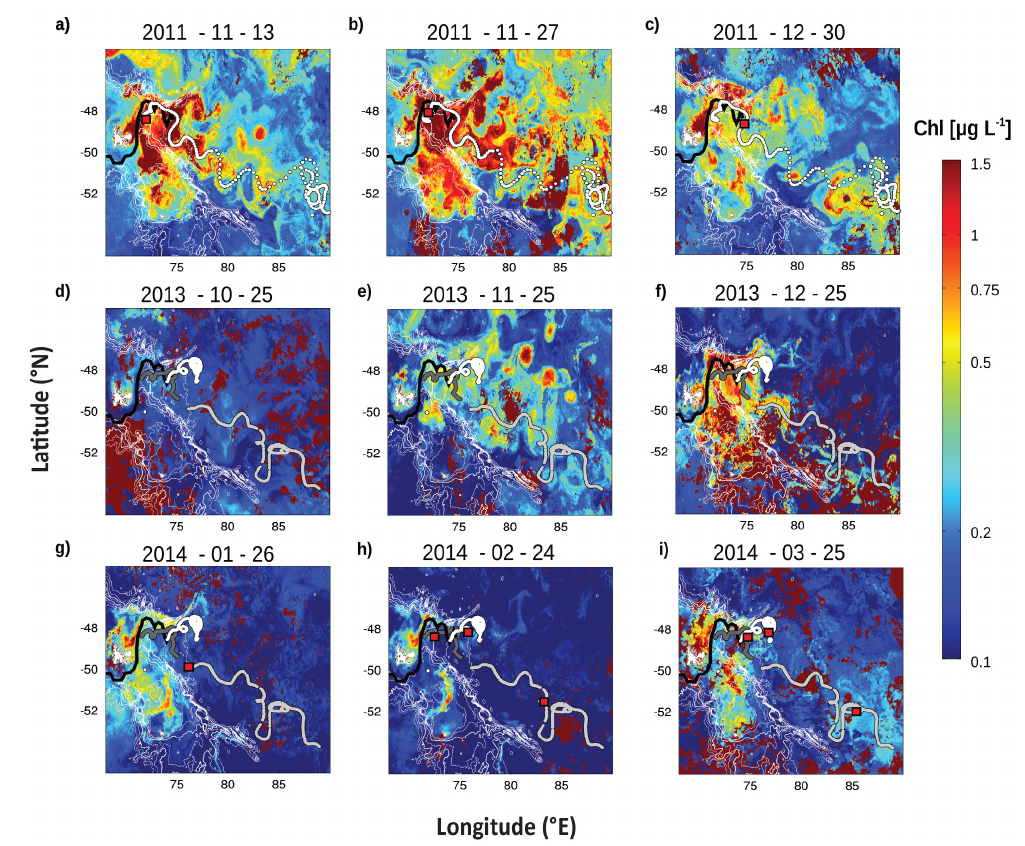
Figure 1. Maps of bio-profiler trajectories (white and grey lines) over remotely sensed chlorophyll a distributions (a–h) : daily, 4km CLS/CNES product; (i) : weekly composite from GlobColour 4km product. Top row: 2011 bloom season for bio-profiler #1. Middle and bottom rows: 2013/2014 bloom and beginning of post-bloom season for bio-profilers #2 (light-grey trajectory), #3 (dark-grey trajectory), and #4 (white trajectory). Red squares indicate the bio-profiler locations corresponding to the day of the image. The thick black line refers to the position of the Polar Front measured from hydrographic samples by Park et al.